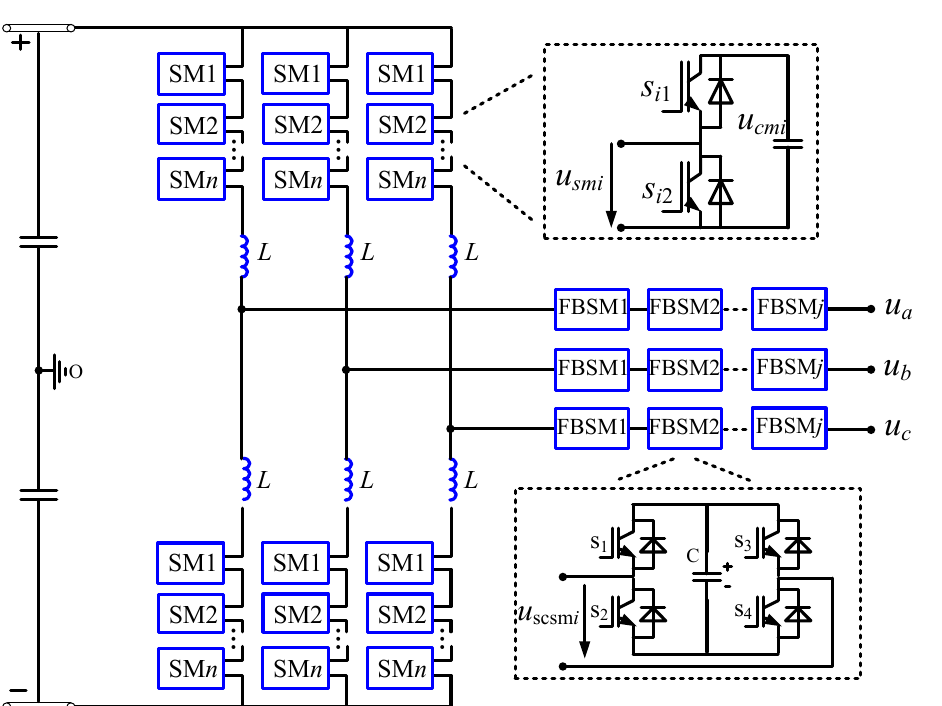
Figure 1. Schematic structure of the hybrid MMC equipped with the FBSMs on the AC side.